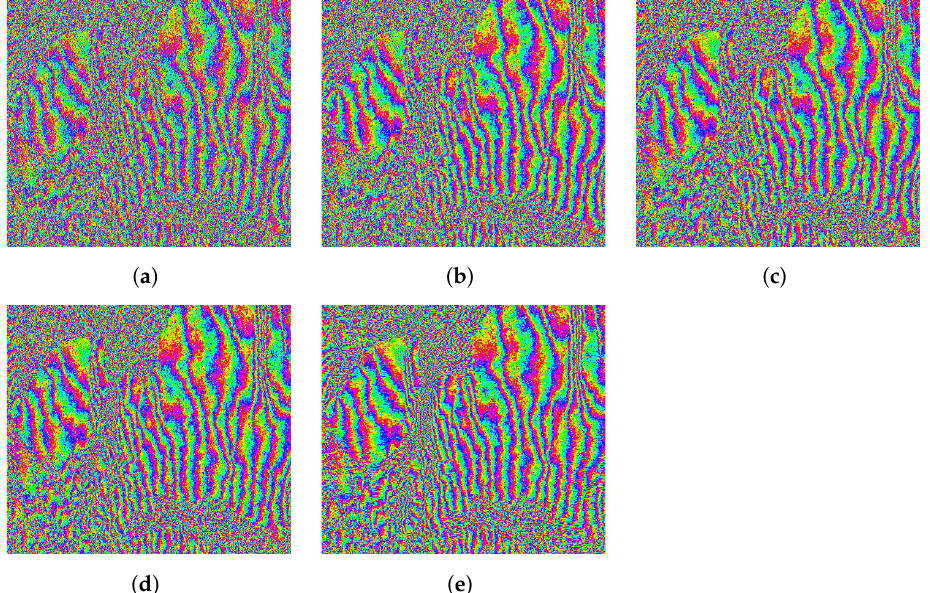
Figure 18. Phase quality improvement after range filtering in a specific region of interest. ( a ) Original. ( b ) Adaptive method. ( c ) Method based on constant slope. ( d ) Slope-adaptive. ( e ) Multi-scale